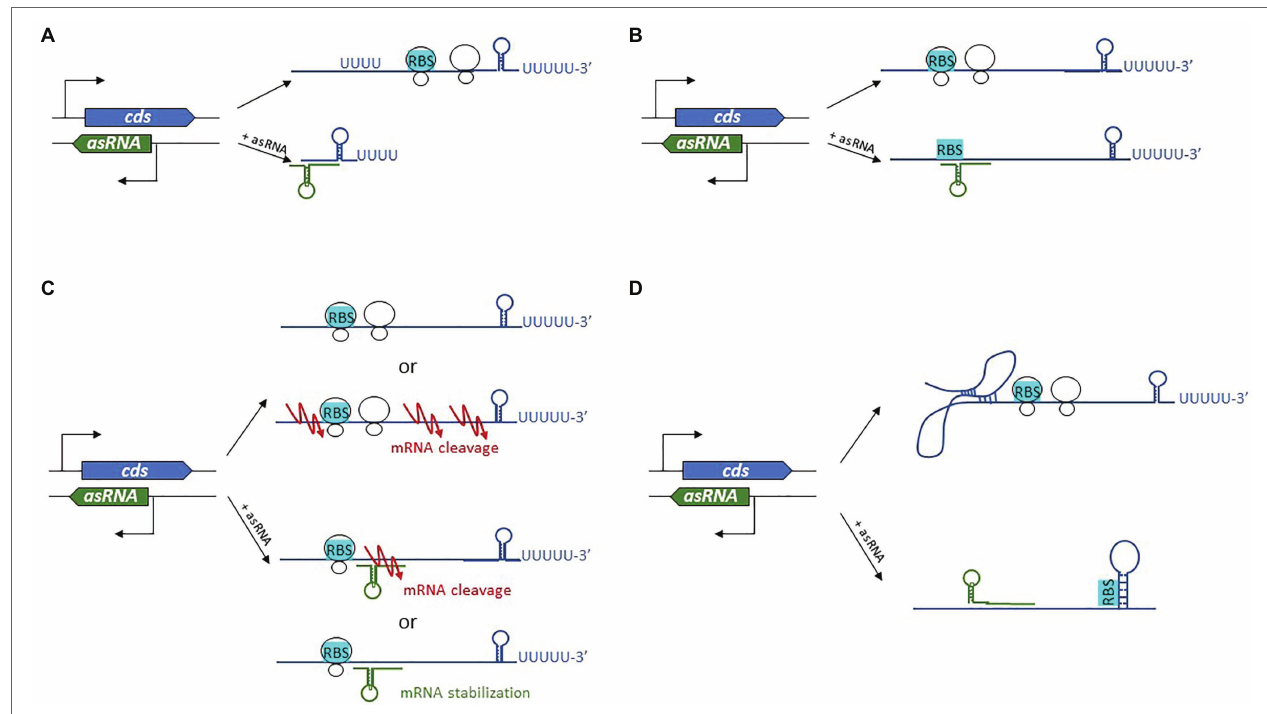
FIGURE 3 | Diverse regulatory mechanisms are employed by cis -encoded antisense RNAs (asRNAs). (A) Premature transcription termination results in transcription attenuation. (B) When ribosomal loading is blocked, translation is inhibited. (C) Modification of mRNA decay after mRNA stabilization or RNase recruitment. (D) RNA pseudoknot formation leads to modified RBS accessibility. cds , coding sequence and RBS, ribosome binding